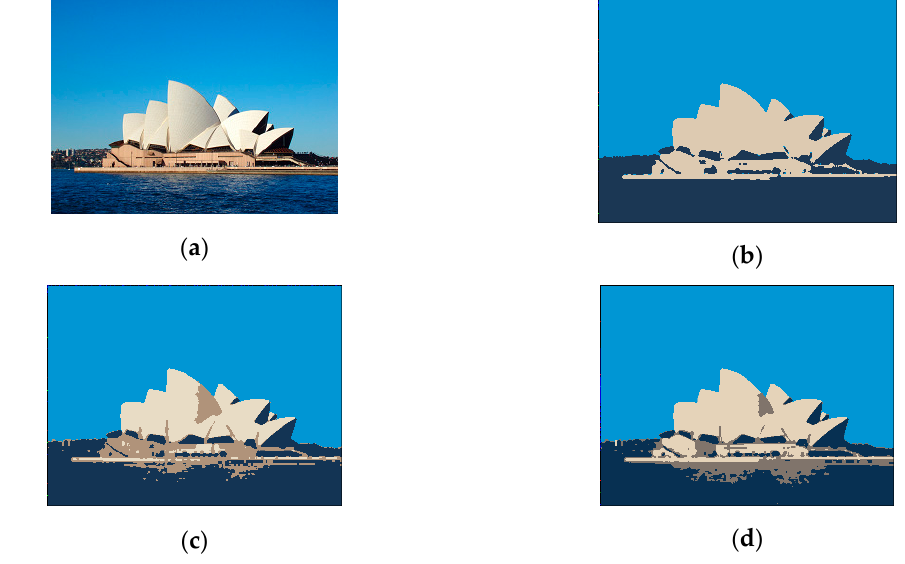
Figure 15. Segmentation results of an image of the Sydney Opera House. ( a ) Original image. ( b ) Ideal image segmentation. ( c ) Segmented image using K-means. ( d ) Segmented image using SOM. Table 1. Comparison of k-means clustering and the SOM neural network.